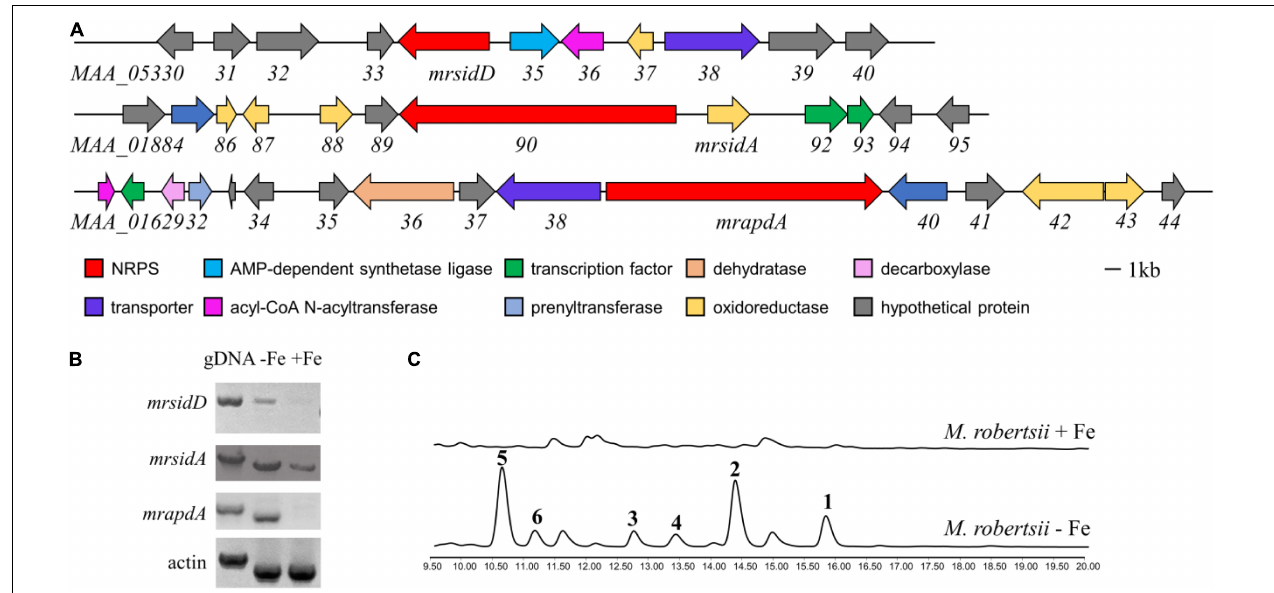
FIGURE 1 | The biosynthetic gene cluster of siderophore and transcriptional analysis of genes related to secondary metabolites under iron deficiency conditions. (A) Gene clusters and putative assignments which increased expression at transcriptional level occurred in iron deficiency; (B) RT-PCR results of gene expression in the conditions of iron-containing and iron-deficient, the expression levels of actin and gDNA were used as control; (C) HPLC traces of M. robertsii in the condition of iron-containing and iron-deficient, UV absorption was monitored at 210 nm. 10 4 / mL conidia of M. robertsii were point inoculated on AMM medium and AMM-Fe medium and incubated for 10 days at 25 ◦ C on a rotary shaker at 150 rpm.